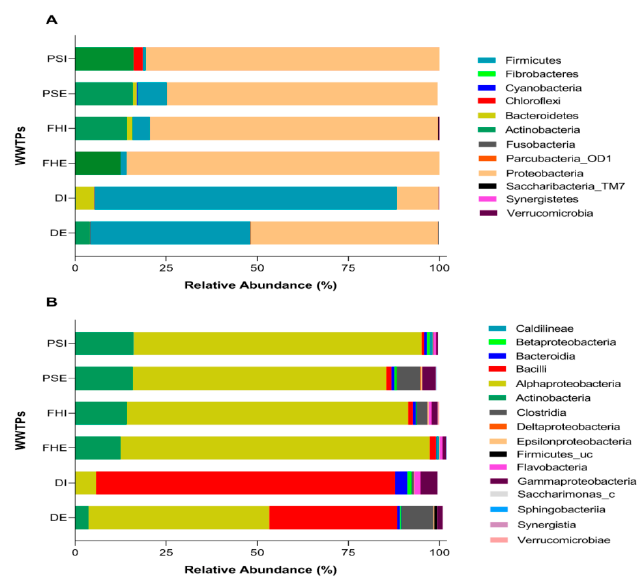
Figure 2. Bar charts showing ( a ) taxonomic distributions of dominant bacterial phyla and ( b ) taxonomic distributions of dominant bacterial classes for the six wastewater samples based on sequence data.